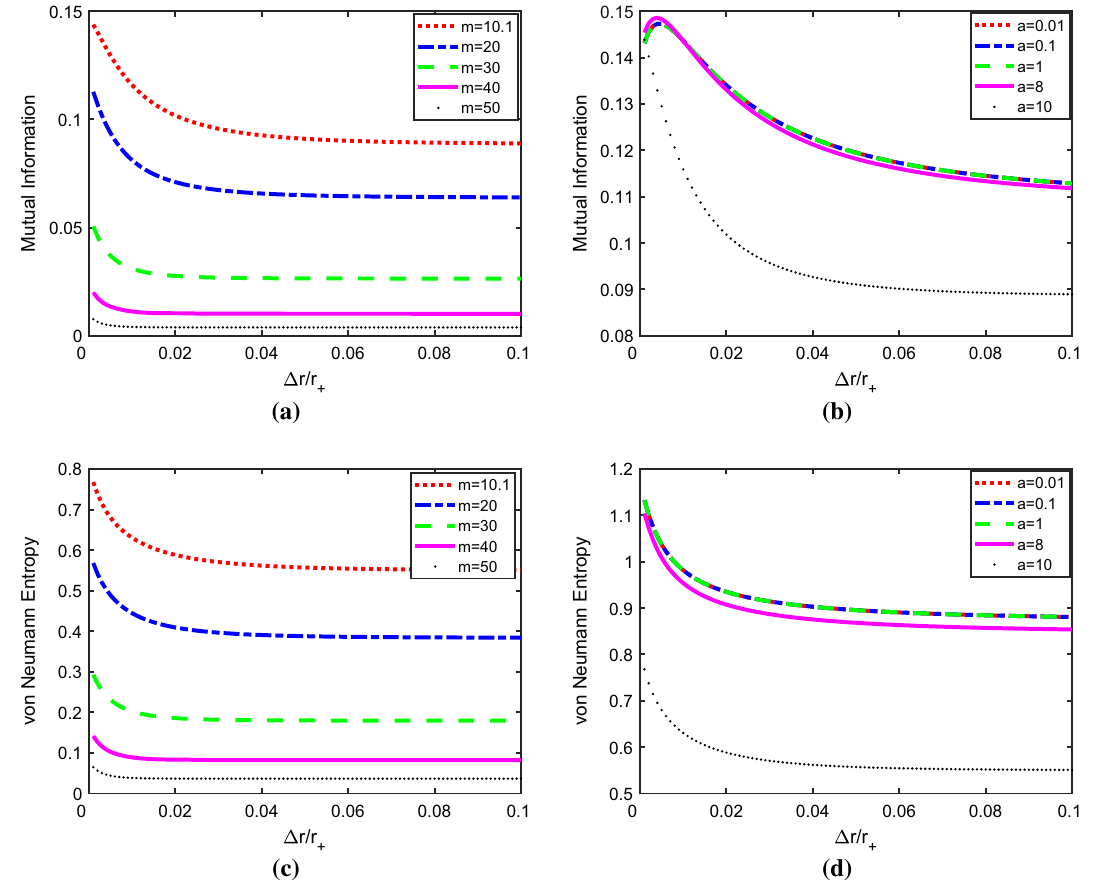
Fig. 13 We consider a nonequilibrium scenario: one of the two atoms is stationary at 1 . 006 r + , while another is at ( 1 . 006 + (cid:2) r ) r + . Quantum correlations at nonequilibrium steady state vary with separation distance for a = 10 or M = 10